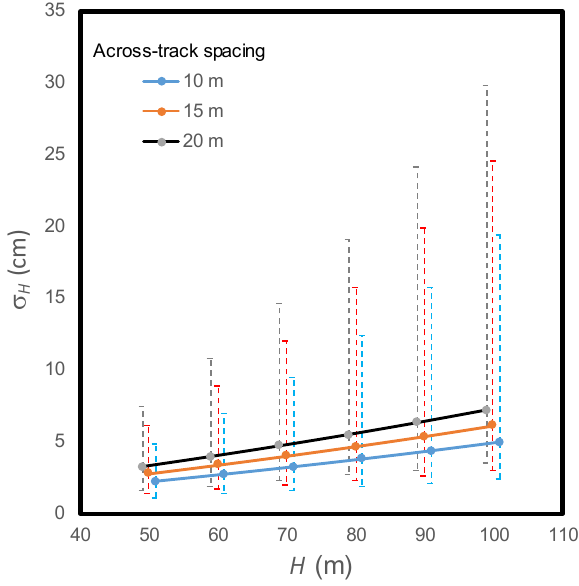
Figure 2. Theoretical relationship between vertical uncertainty and UAV height. Solid lines correspond to five matching images per key point. Upper (lower) bars correspond to three (eight) matching im- ages per key